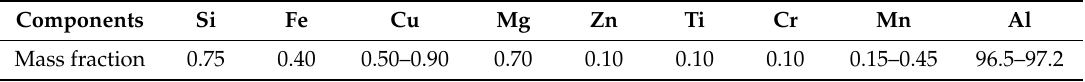
Table 1. Chemical composition of 6111 aluminum alloys (wt.%), data from [14].